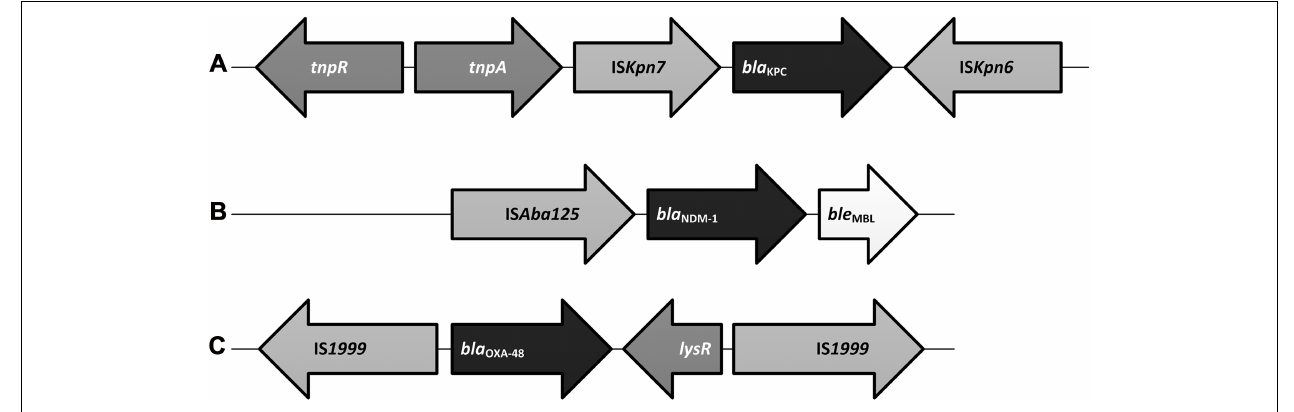
FIGURE 1 | Basic genetic construct of select carbapenemase genes. (A) Schematic representation ofTn 4401 type of transposon associated with bla KPC which includes a transposase gene ( tnp A), a resolvase gene ( tnp R), as well as insertion sequences, IS Kpn6 and IS Kpn7 (Cuzon etal., 2010). (B) The bla NDM − 1 construct demonstrates IS Aba125 insertion sequence(s) upstream